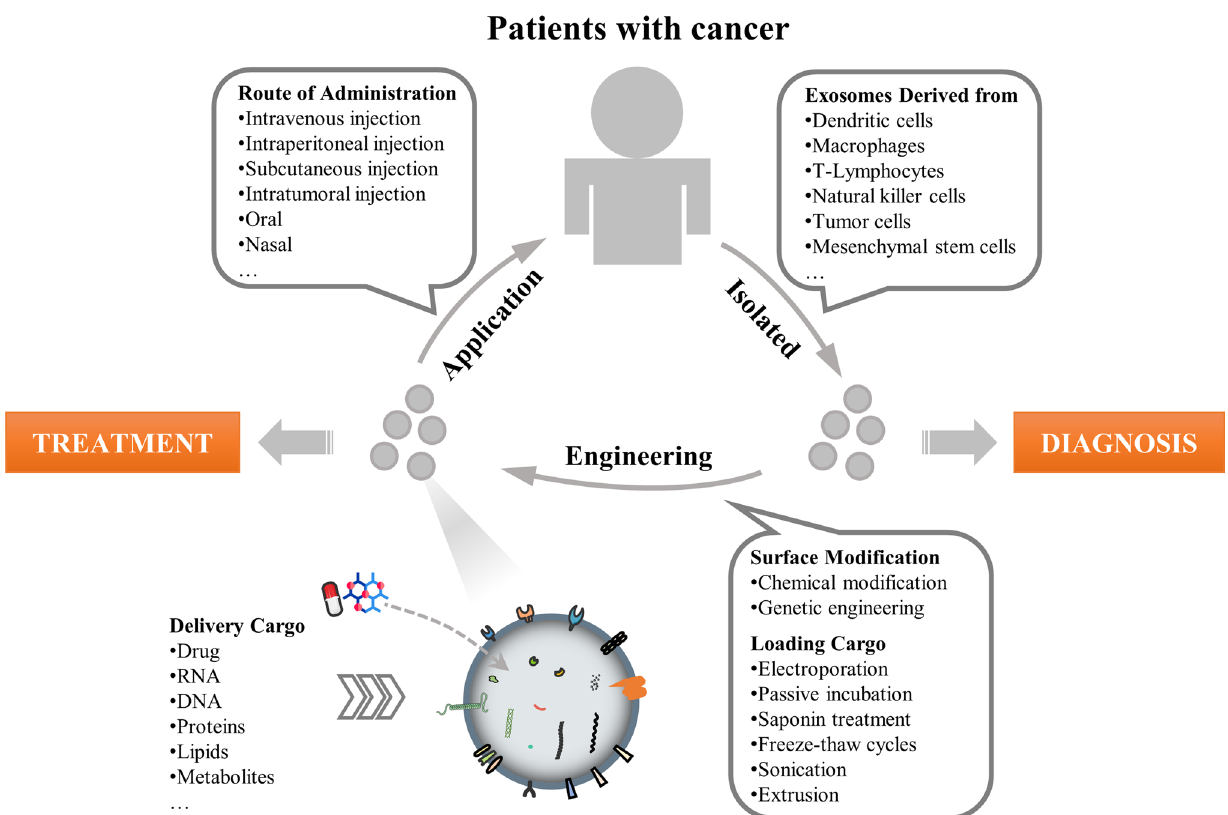
Fig. 1 Exosome-based cancer diagnosis and treatment. Exosomes from different sources can be used for cancer diagnosis. Exosomes can be used as drug delivery systems for cancer